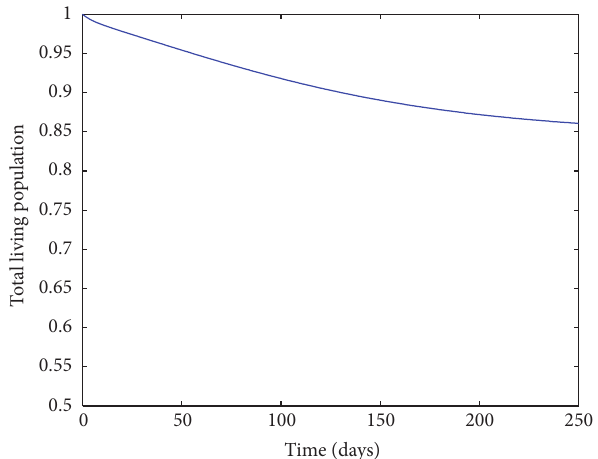
Figure 6: Evolution of the total alive population with a daily culling rate of 𝜌 𝐷 = 0.8 .